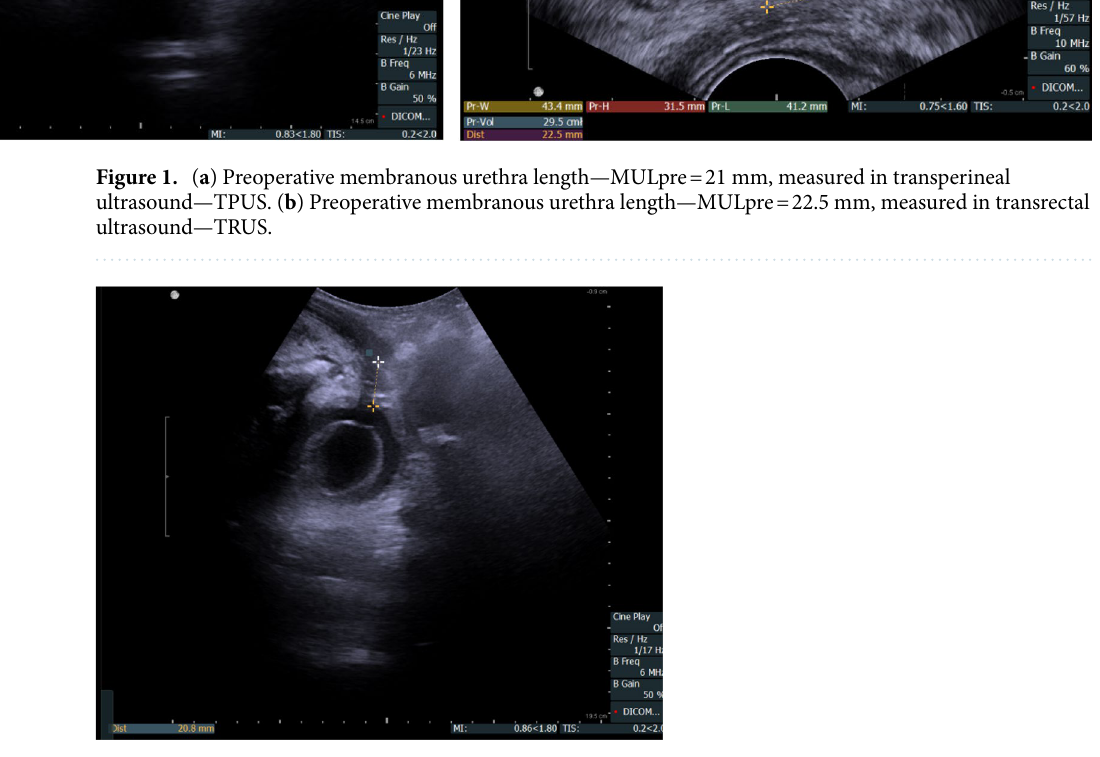
Figure 2. Transperineal ultrasound (TPUS) postoperative membranous urethra length (MULpost) measurement—MULpost = 20.8 mm. MULpost was measured after gentle cranial displacement of the catheter, 8 days after